Question: Sum up the contents of this chart in one sentence.
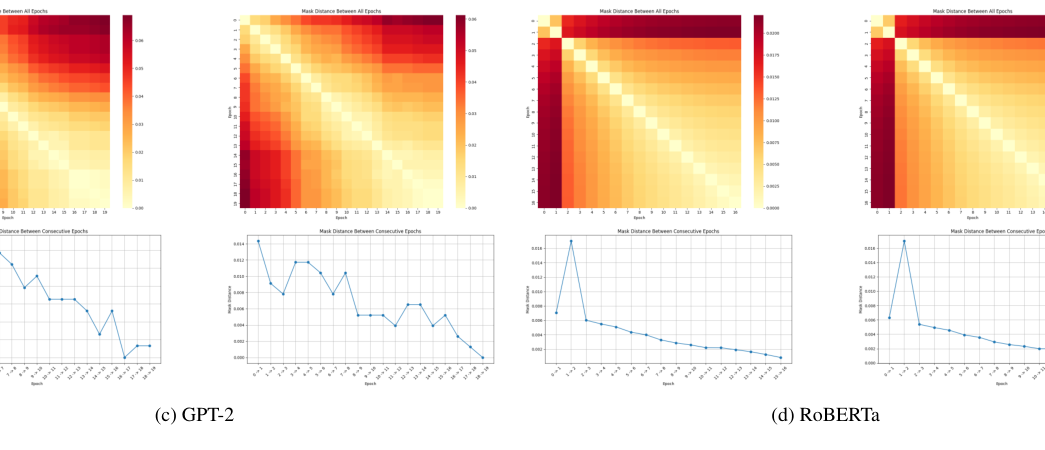
Answer: Heatmaps and mask distance plots at p = 0.1 (to the left) and 0.3 (to the right) for all models